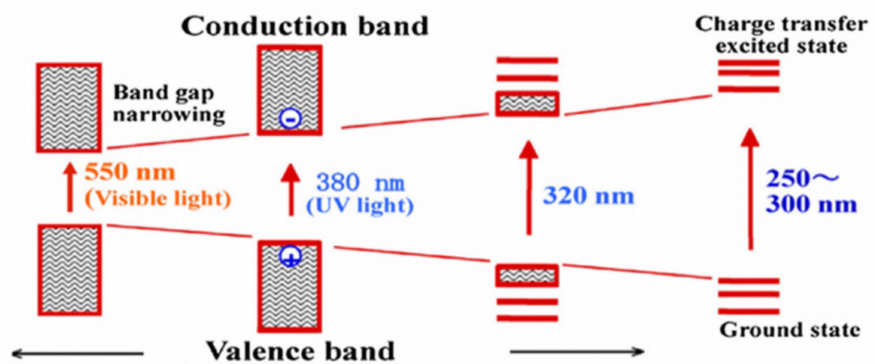
Figure 9. Narrowing and expansion of band gap of semiconductor and wavelength of incoming light. Reprinted with permission from Elsevier, 19 December 2021 Ref.